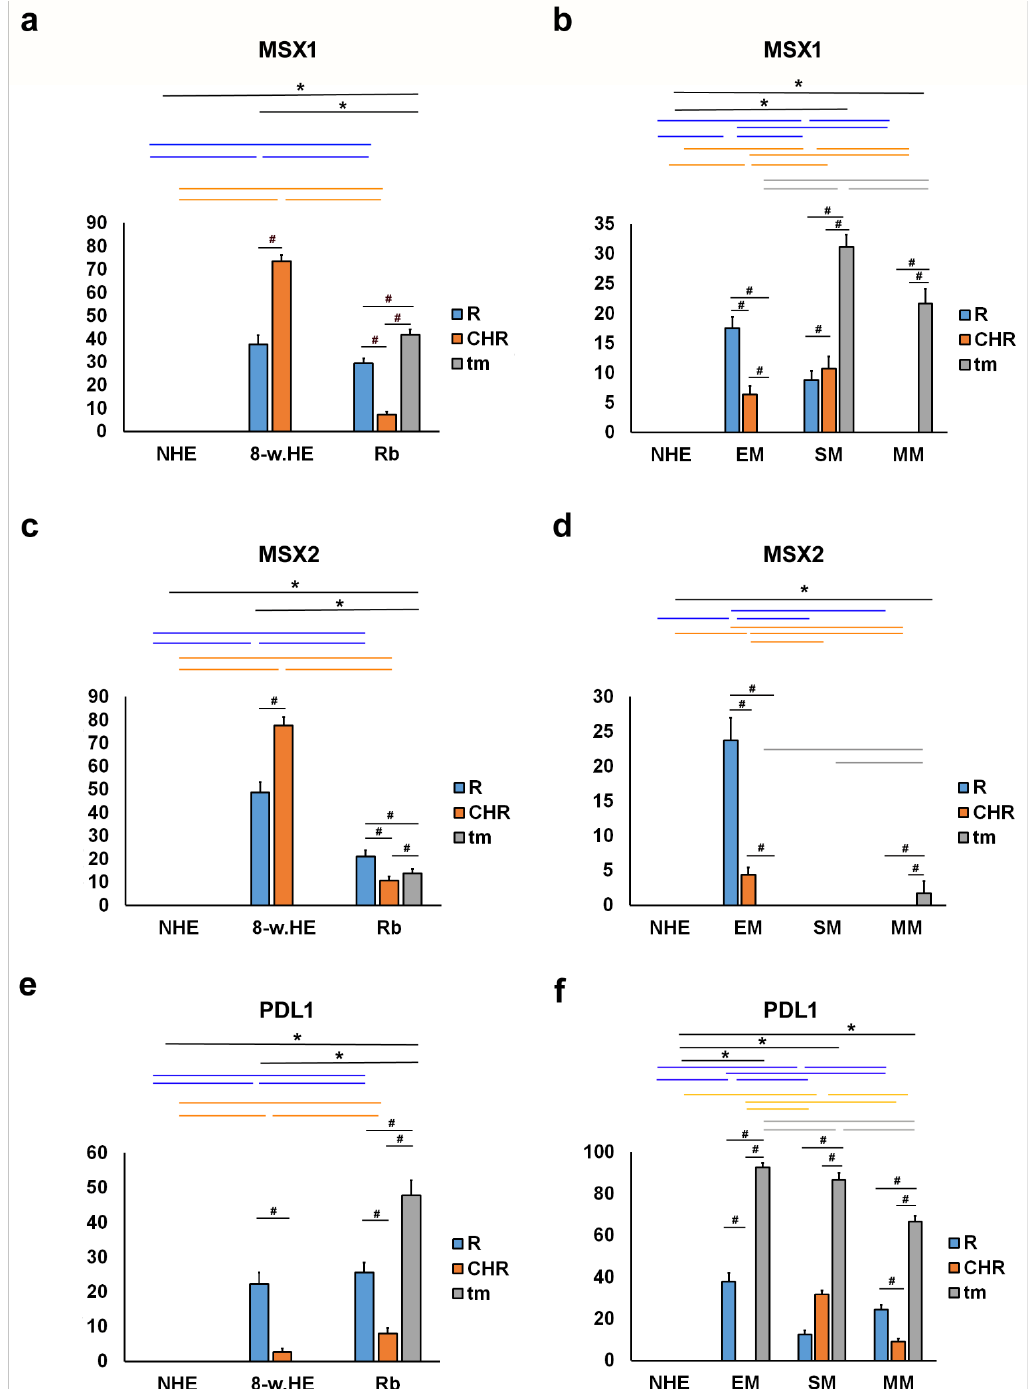
Figure 5. Quantitative analysis of MSX1, MSX2 and PDL1 expression. The threshold area percentage of MSX1, MSX2 and PDL1 in the normal human eye (NHE), the eye section of an 8-week human embryo (8-w.HE), retinoblastoma (Rb), epithelioid melanoma (EM), spindle melanoma (SM), and myxoid melanoma (MM). Data are shown as mean ± SD. #—statistically significant differences (comparison between retina, choroid and tumor in the same specimens); blue line—statistically significant differences-comparison of the retina between NHE, 8-w.HE, tumor and different type of melanomas); grey line—statistically significant differences-comparison of the tumor tissue between different type of melanomas; *—statistically significant differences (comparison between Rb and retina or melanoma and choroid) (ANOVA and Tukey post-hoc test). All significant differences are presented in Supplementary Tables